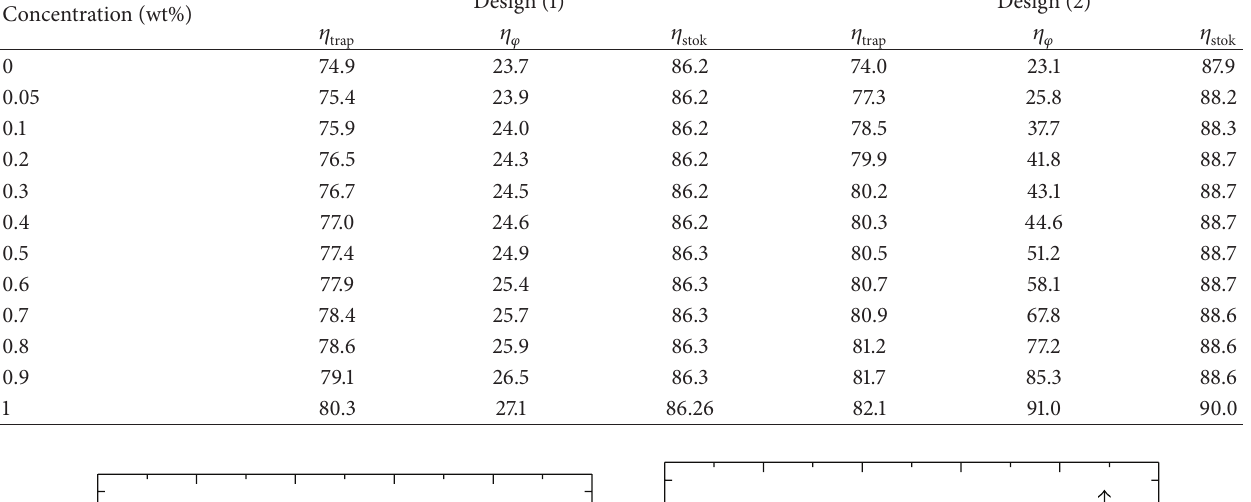
Table 1: The effect of nanosilica concentration on the efficiency parameters (%) 𝜂